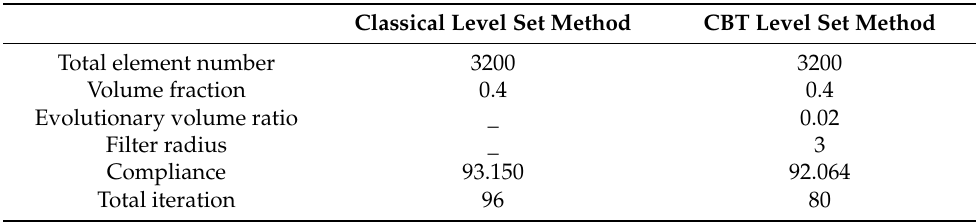
Table 4. Results for topology optimization of cantilever beam.